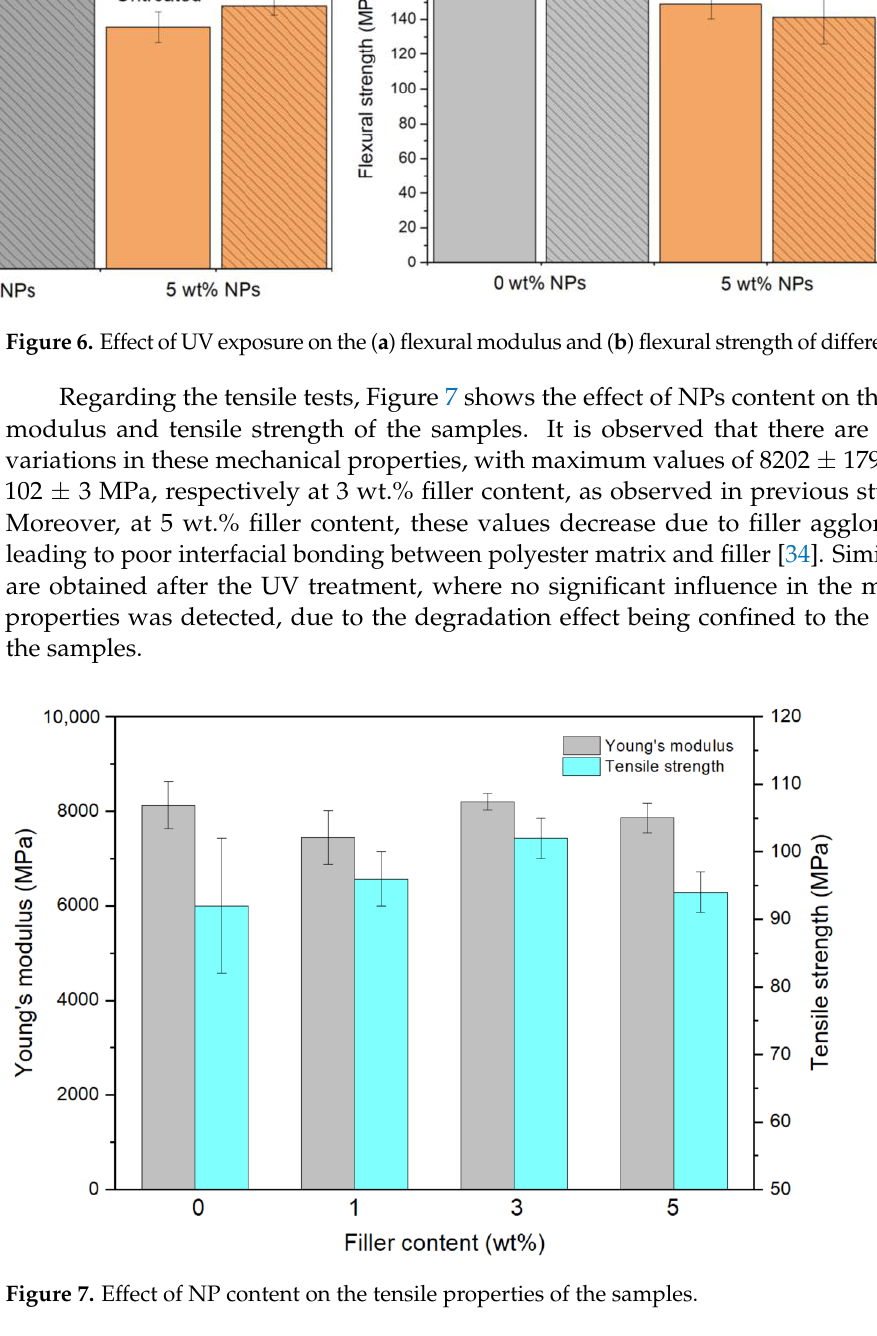
Figure 7. Effect of NP content on the tensile properties of the samples.